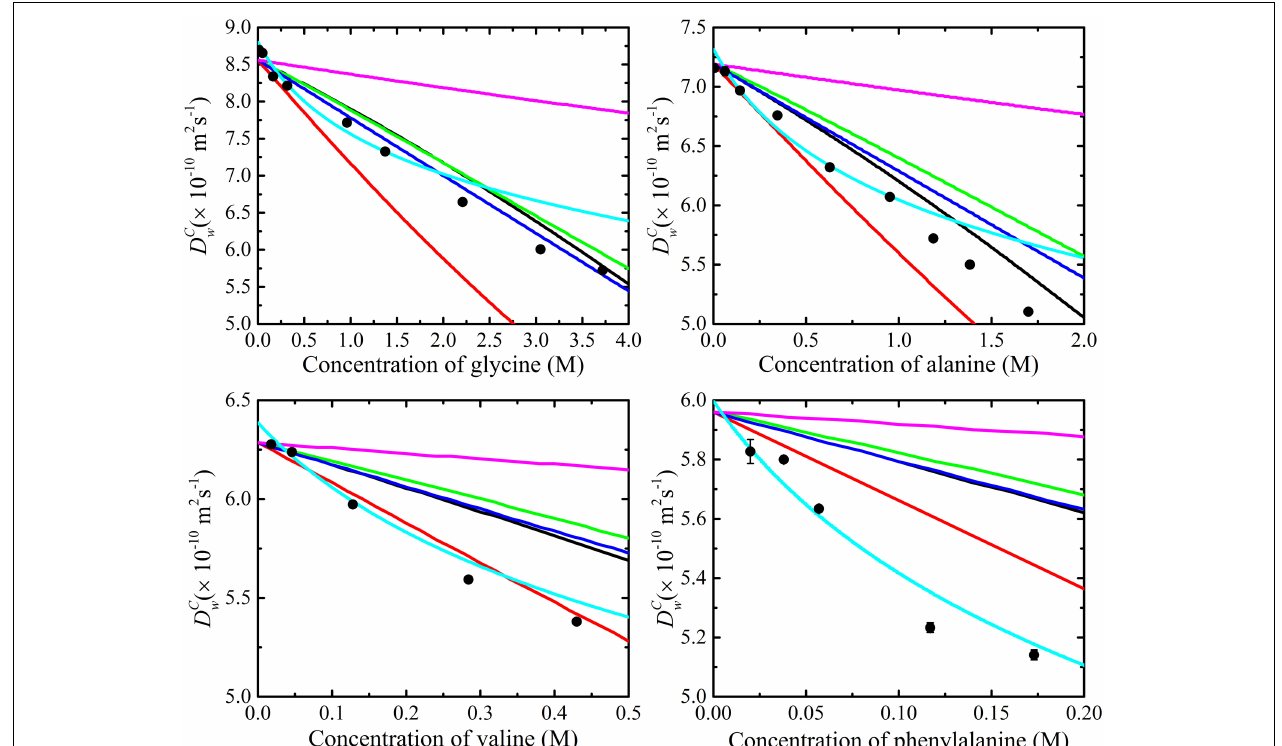
FIGURE 6 | The measured diffusion coefficients ( (cid:129) ) of glycine, alanine, valine, and phenylalanine in D 2 O at 298 K as a function of amino acid concentration modeled using obstruction and aggregation models separately (i.e., Equation 12 with N = 1). Clearly, none of the current obstruction models [i.e., Lekkerkerker and Dhont ( ) [72], Han and Herzfeld ( ) [49], T and O’s short interactions model ( ), T and O’s long interactions model ( ) [71], and Jönsson et al. ( ) [66], fit to the experimental data well. Also shown is the fitting of the isodesmic (i.e., Equation 11) aggregation model ( ) [65] to the experimental data. The measured diffusion coefficients are lower than those predicted by the